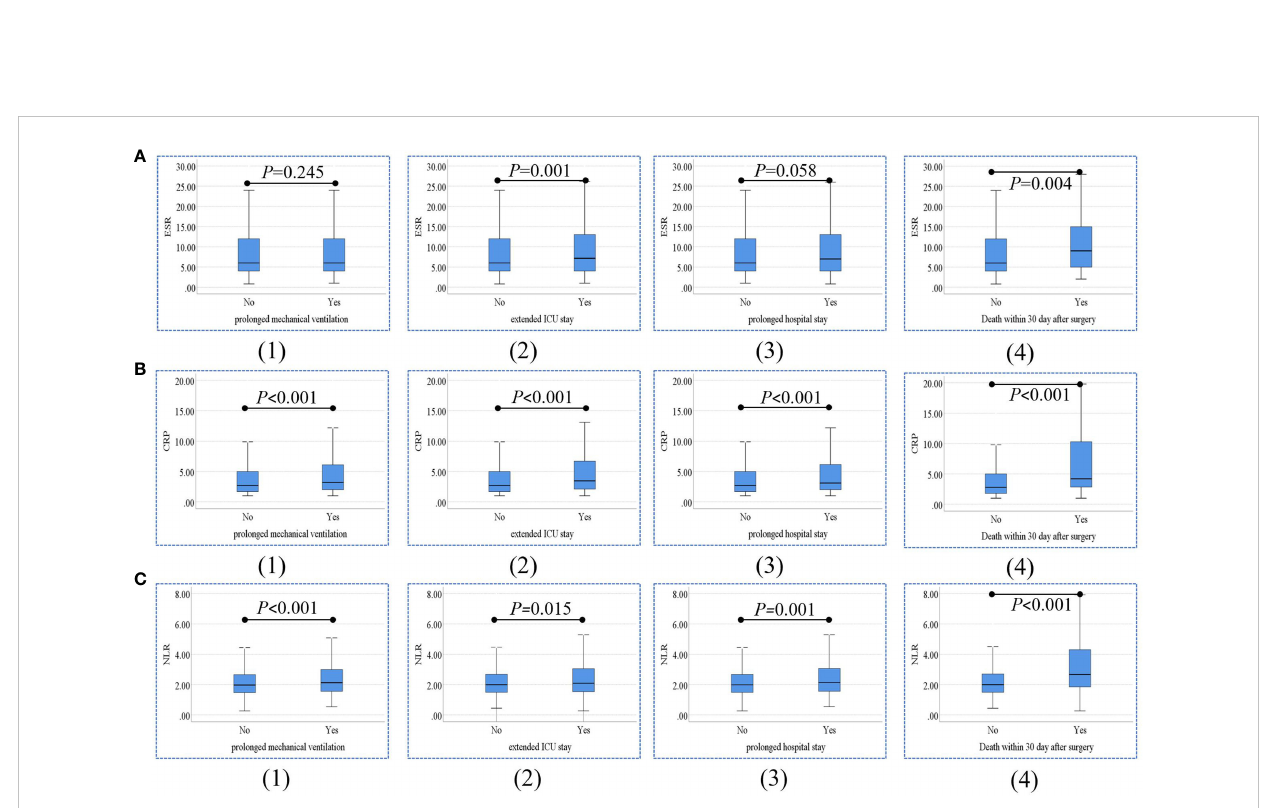
FIGURE 3 Comparisons of ESR (A) , CRP levels (B) , and NLR (C) between patients with and without prolonged mechanical ventilation (1), extended ICU stay (2), prolonged hospital stay (3), and death within 30 days after surgery (4). ESR, erythrocyte sedimentation rate; CRP, C-reactive protein; NLR, neutrophil-to-lymphocyte ratio; ICU, intensive care